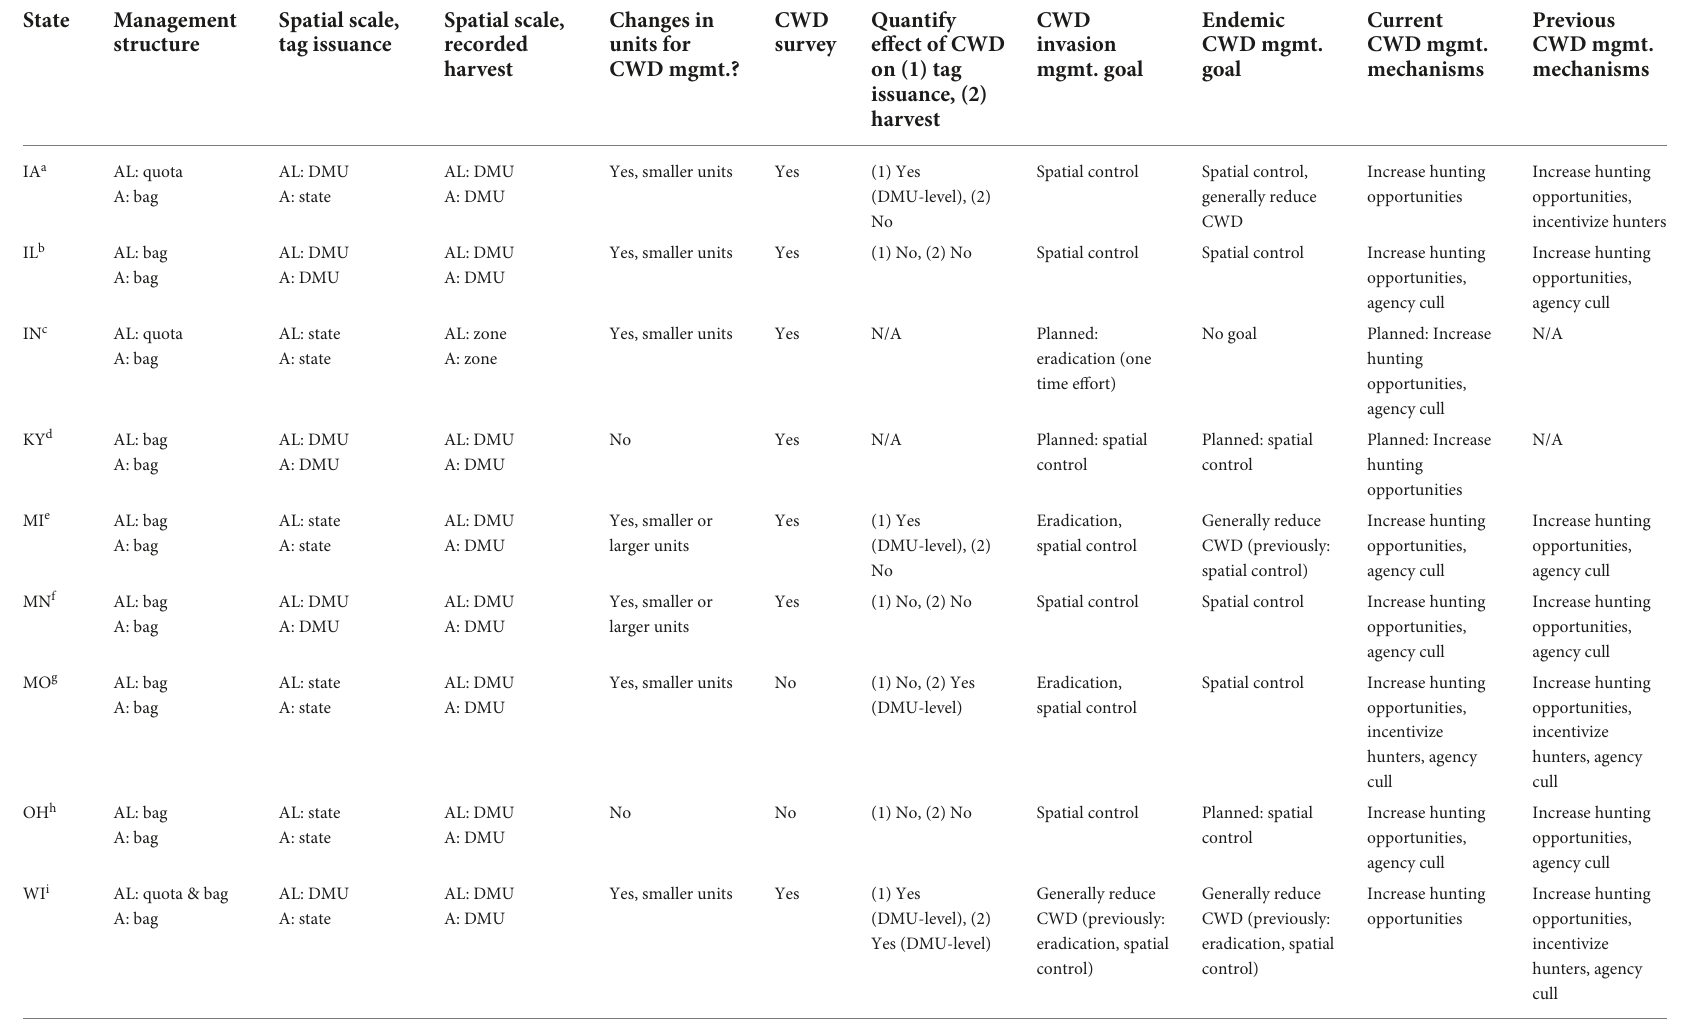
TABLE 1 Summary of white-tailed deer management and resolution of data collection in Midwestern states.